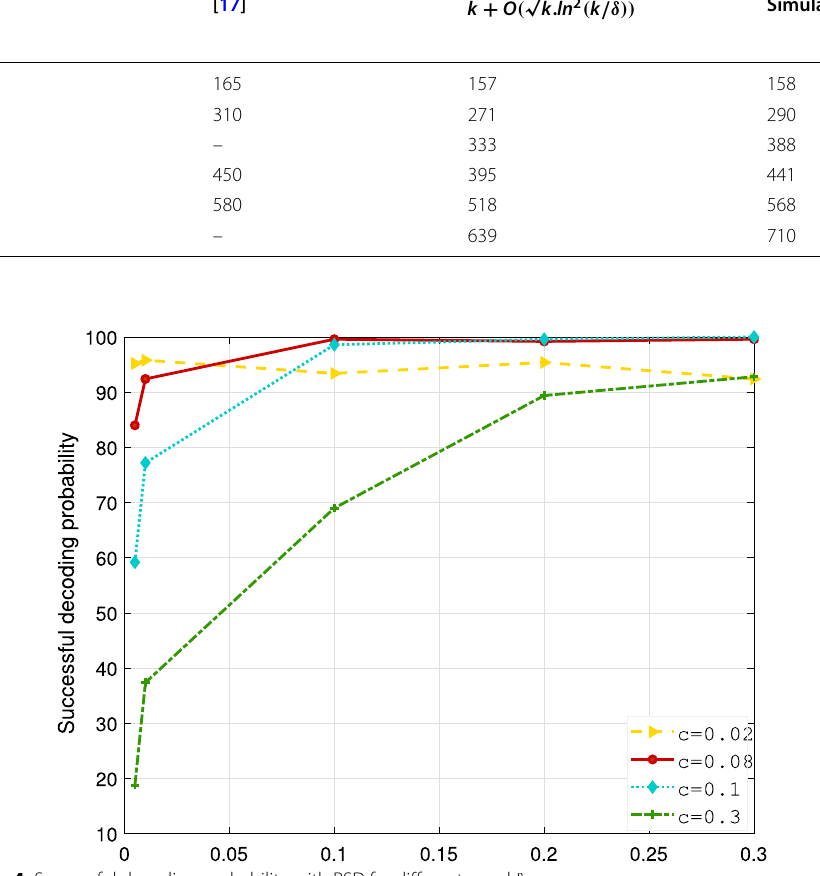
Fig. 4 Successful decoding probability with RSD for different c and